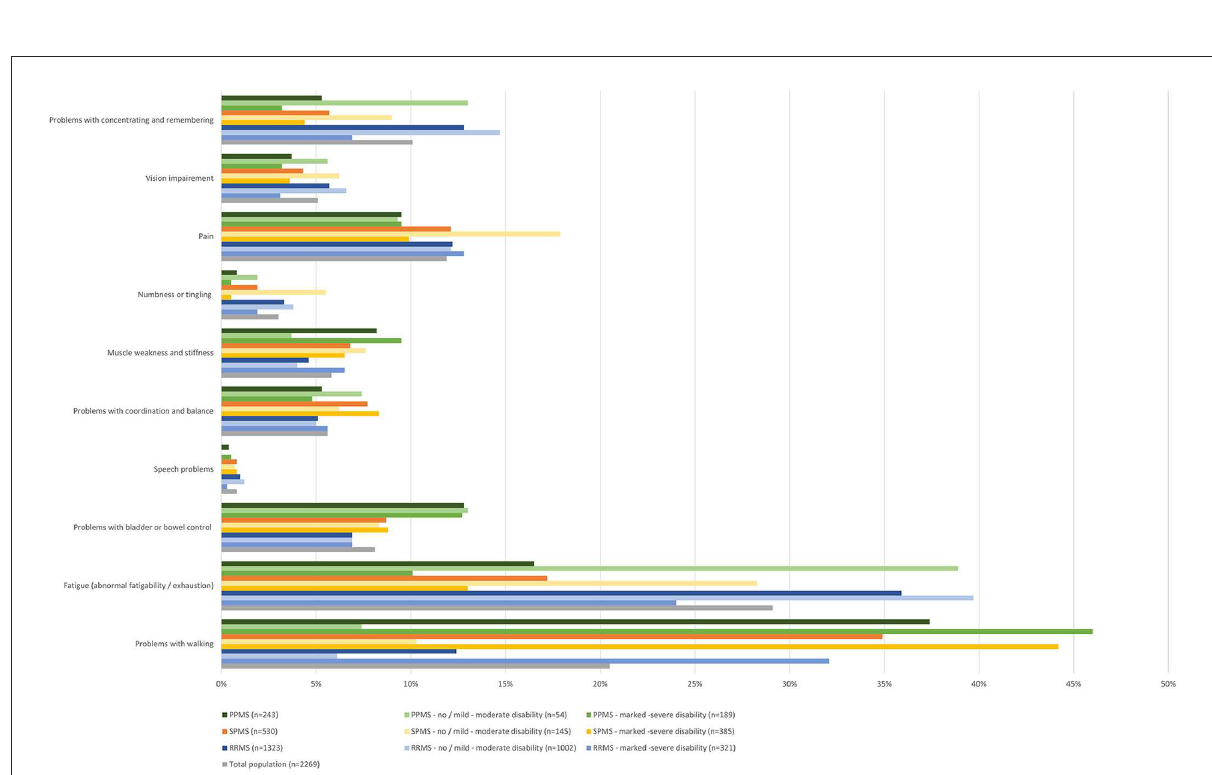
FIGURE4 Most disabling symptoms worsened in the last 12 months independent of relapses (total population, by subtype, by disease